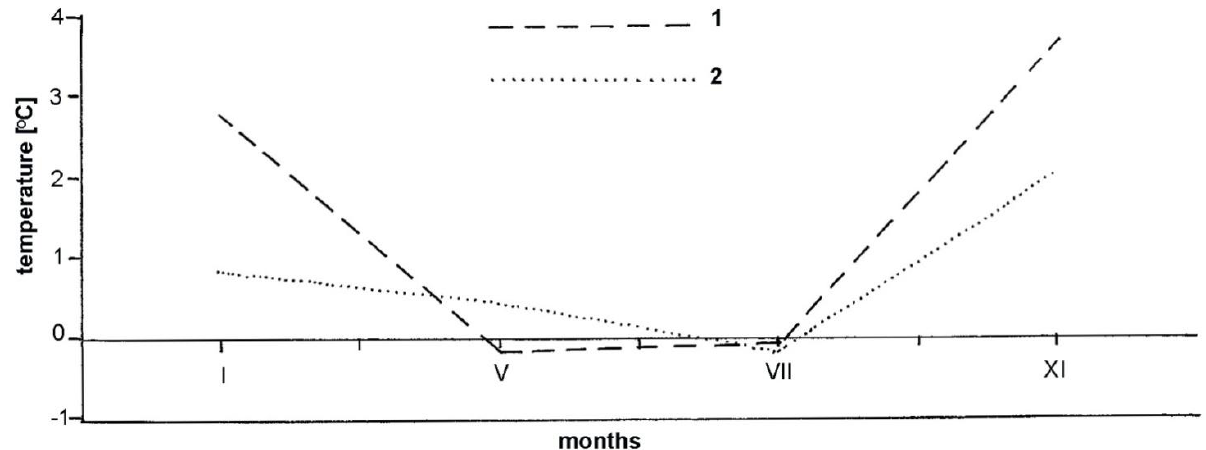
Fig. 2. The average monthly changes in air temperature in the region of the Ust-Ilimsk reservoir (after Gustokashina & Balybina, 2005) 1 – coastal stations; 2 – continental